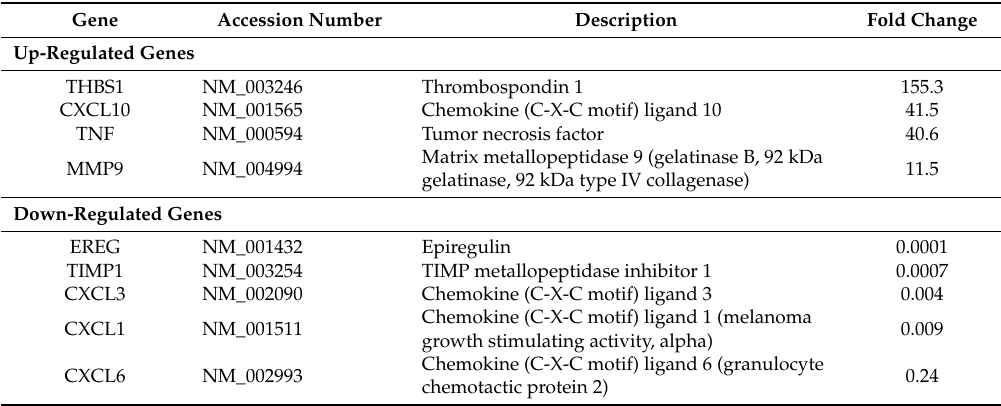
Table 2. List of selected differentially expressed genes modulated by MDM2 transfection in LNCaP prostate cancer cells, analyzed using PCR array.